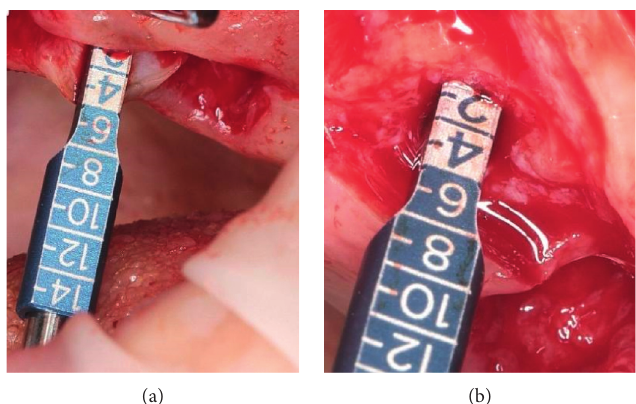
Figure 4: Control of the reduction depth: (a) measurement of the thickness of the attached mucosa; (b) measurement of the reduction depth of the alveolar ridge.